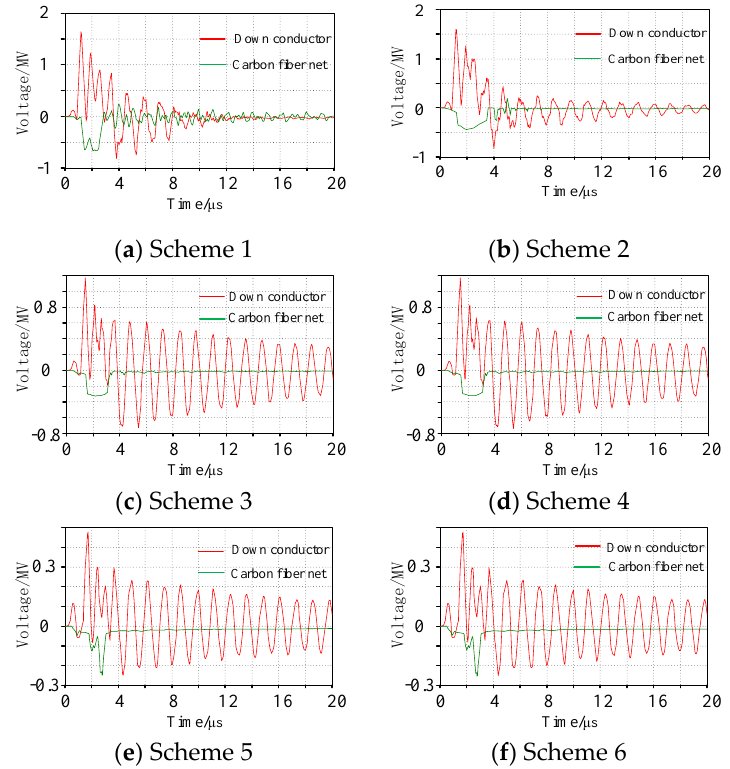
Figure 9. Voltage between the down-conductor and CFN with various installation schemes. Table 5. Voltage between the down-conductor and CFN with various installation schemes. Scheme